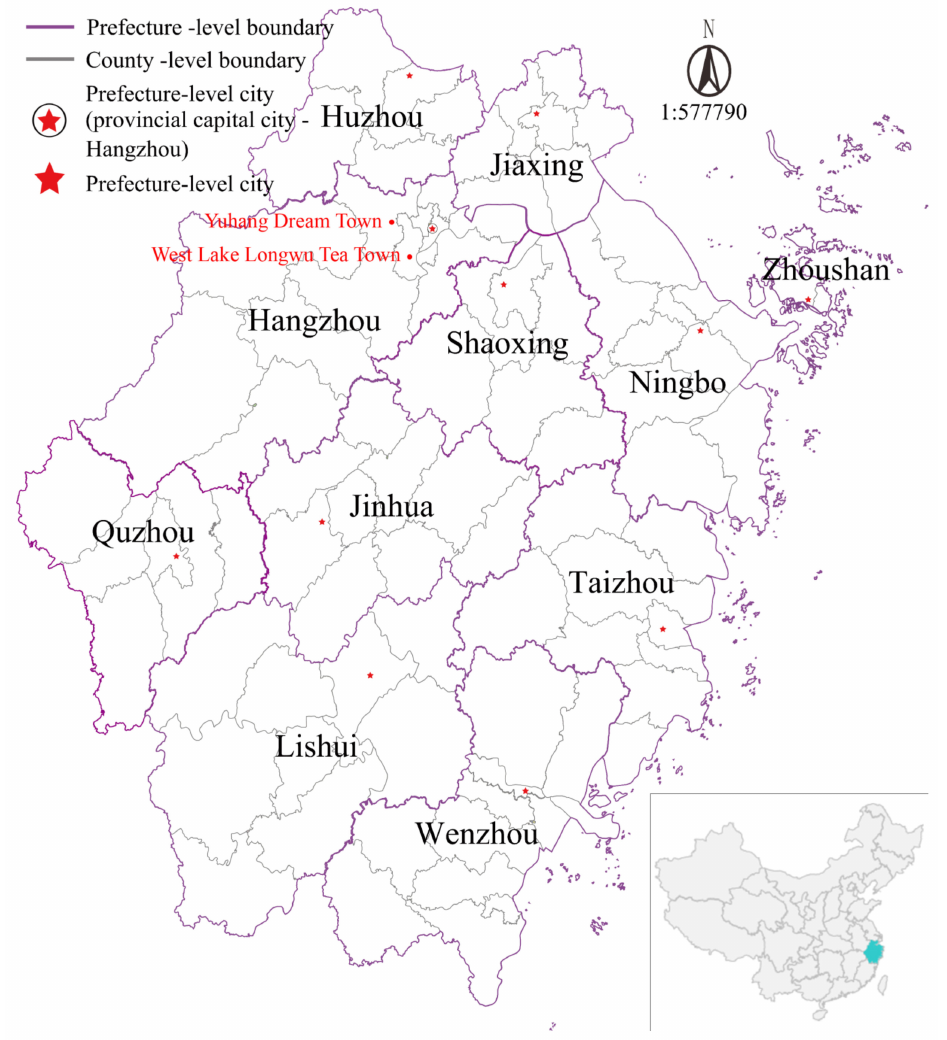
Figure 1. Geographical location of the cases (source: